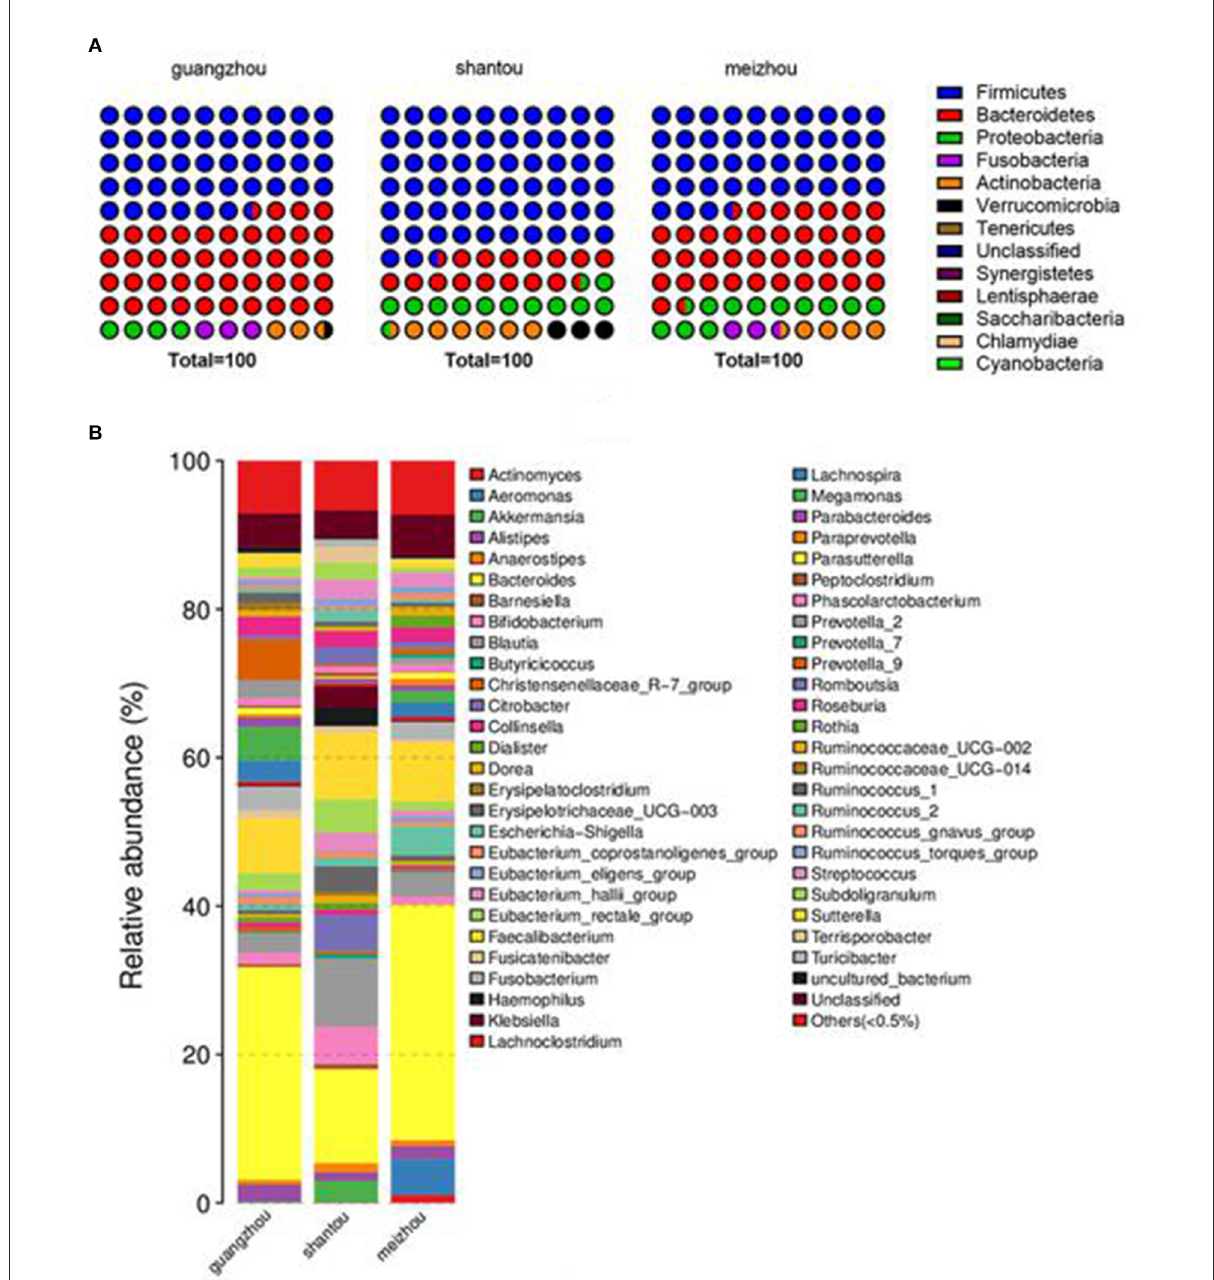
FIGURE3 Distribution of intestinal microbes at different taxonomic levels in Guangzhou, Meizhou and Shantou populations. Two levels of dominant taxa are shown (Others: < 0.5% relative abundance). (A) Distribution at the phylum level. (B) Distribution at the genus level.